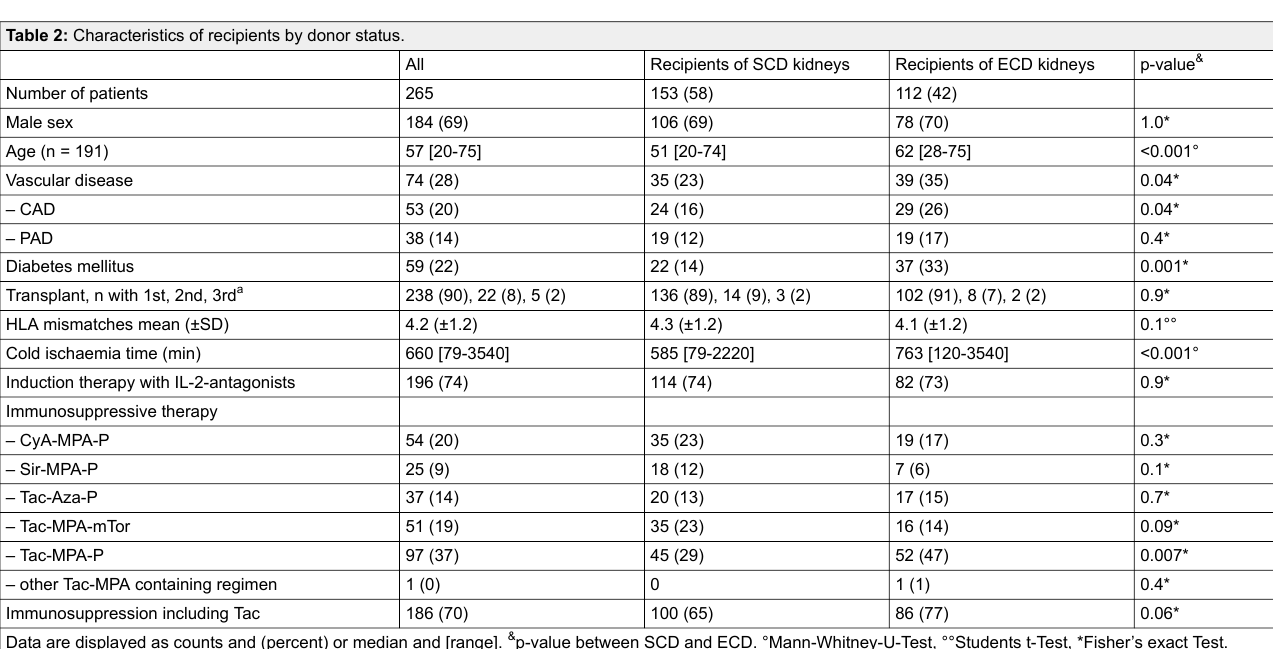
Table 2: Characteristics of recipients by donor